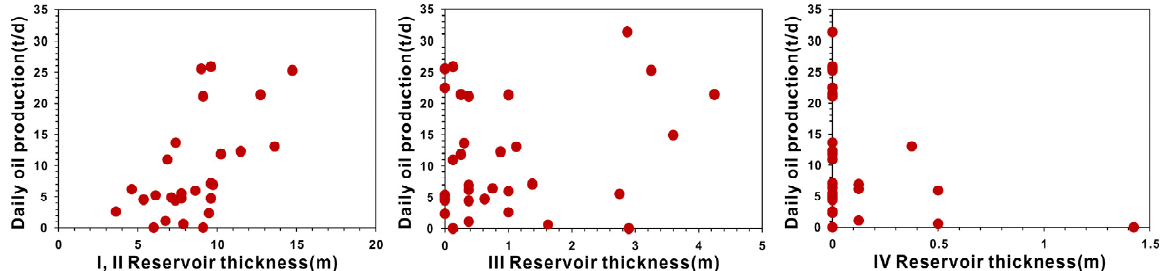
Figure 17. Relationship between different types of reservoirs and daily production of oil testing in the Chang 7 1-2 sub-member (oil test results). Table 2. Different types of reservoirs with single well daily production.